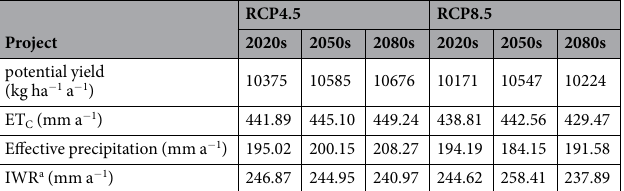
Table 3. The changes of main factors of winter wheat in Huang-Huai-Hai Plain in different time in the future. Notes: a IWR represents irrigation water requirements, mm a − 1